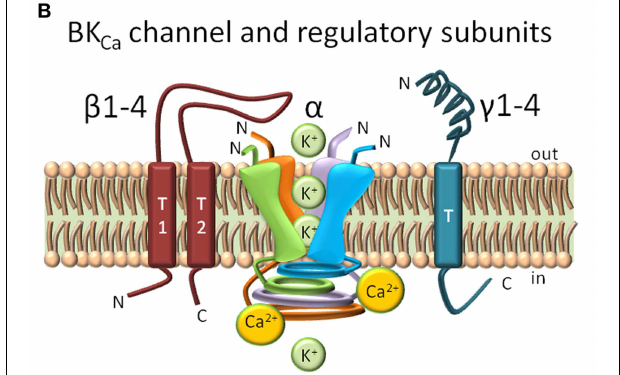
FIGURE 1 | Structural domains in BK Ca channels and regulatory subunits. (A) BK Ca is composed by 7 transmembrane domains (S0–S7) and a long intracellular C-terminus. S0–S4 form the voltage sensing domain, and S5–S6 conform the pore-gating domain. Ca 2 + biding sites are highlighted in the Regulator of Potassium Conductance (RCK) 1 and RCK2 domains. A C-terminal 50 amino acid splice insert, DEC, is highlighted. (B) Regulatory BK Ca subunits. Homotetramer model of the pore-forming α subunit, the two spanning domain regulatory β subunits (1–4), and single spanning domain γ (1–4) subunits. The loop of β 4 subunit confers to BK Ca α subunit its resistance to toxin inhibition (Meera et al.,